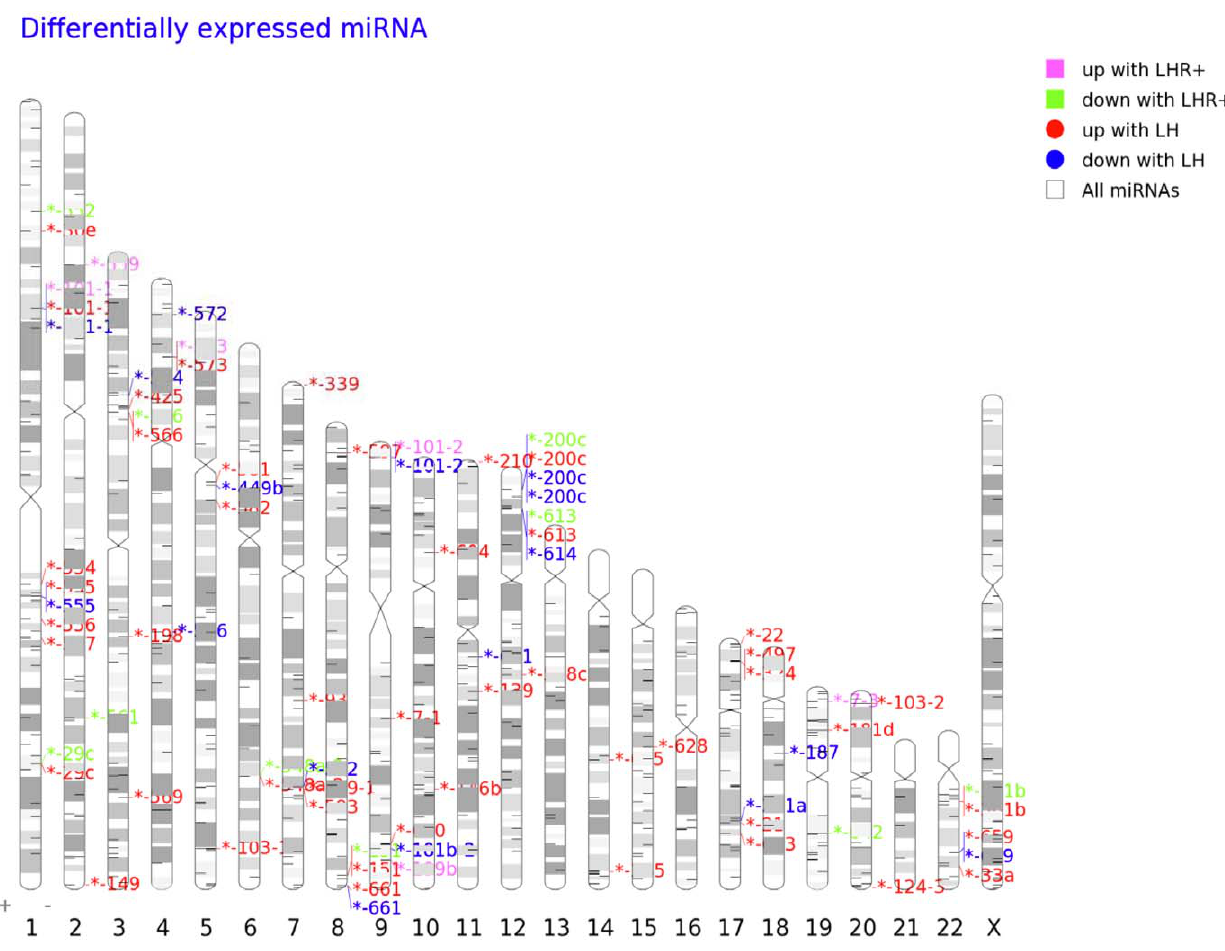
Figure 1. Mapping of differentially expressed microRNAs to the human genome.